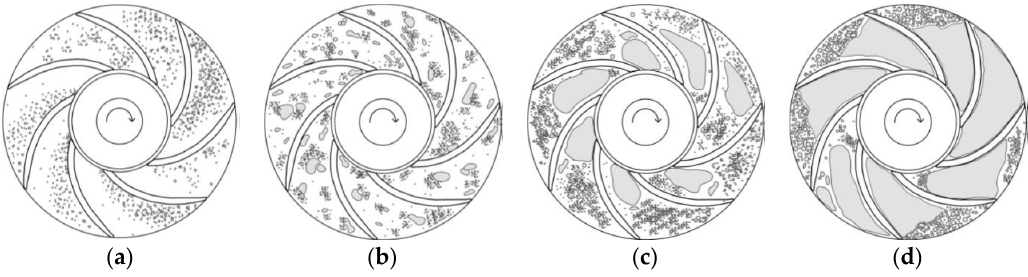
Figure 11. Schematic representations of flow patterns inside a rotating ESP impeller [70], ( a ) bubble flow; ( b ) agglomerated bubble flow; ( c ) gas-pocket flow; ( d ) segregated flow.